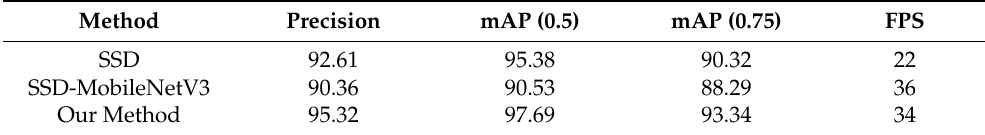
Table 4. Results of different networks tested at the